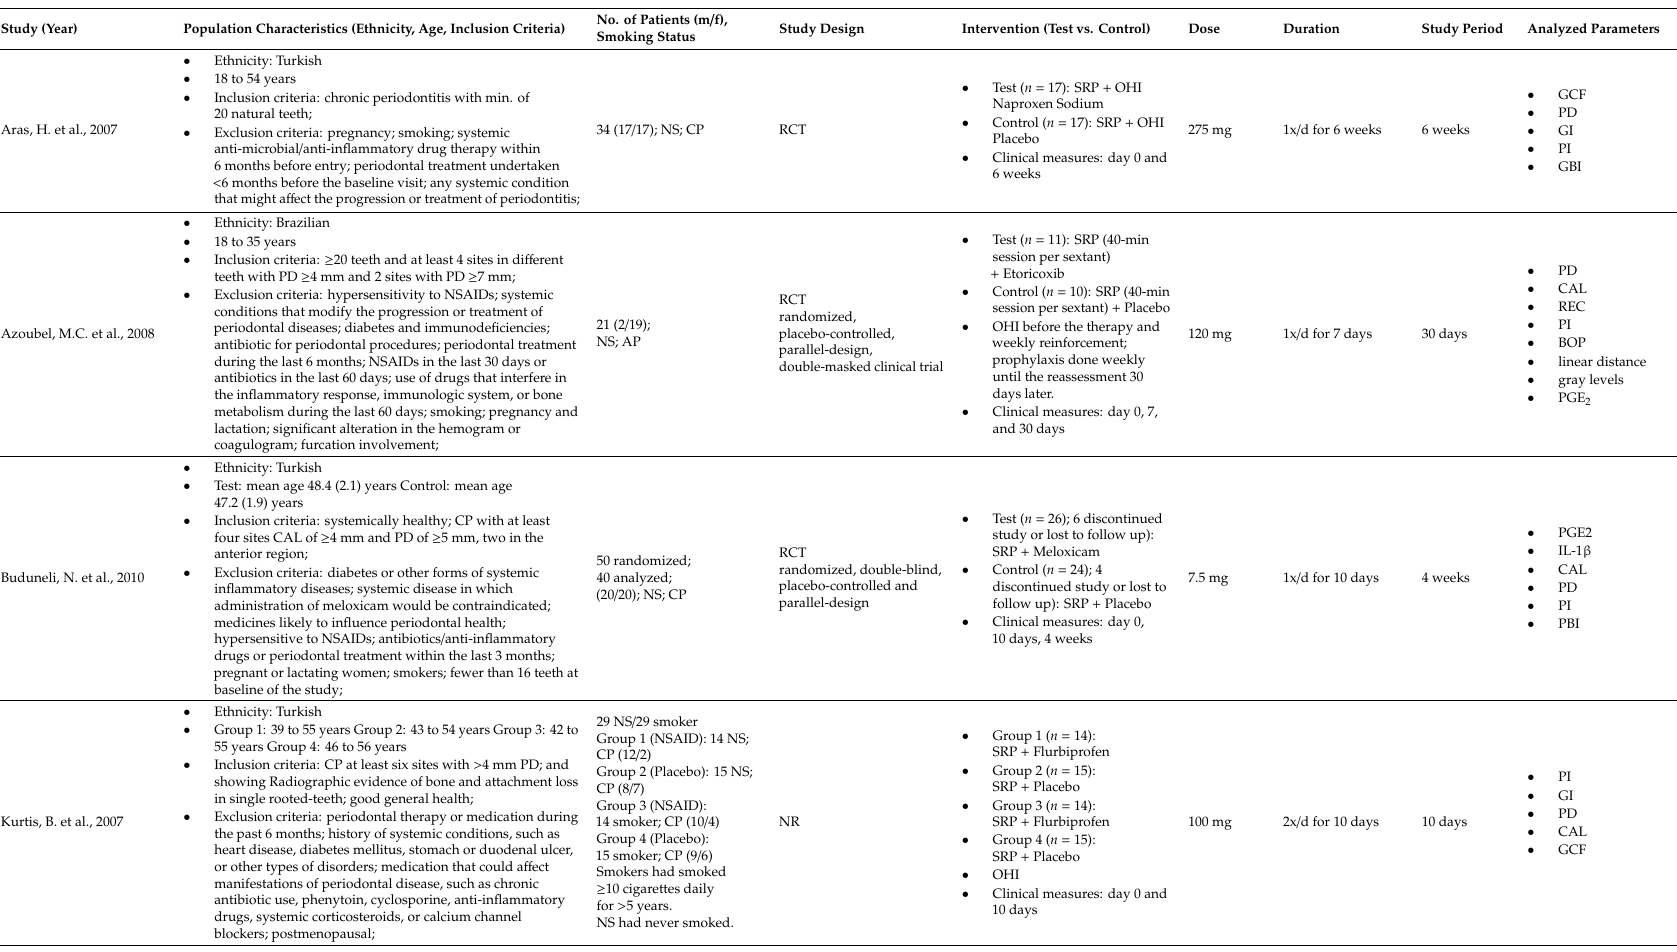
Table 1. Characteristics of the included publications comparing nonsteroidal anti-inflammatory drugs (NSAID)f to placebo. / f), Study(Year) PopulationCharacteristics(Ethnicity,Age,InclusionCriteria) No. ofPatients(m SmokingStatus StudyDesign Intervention(Testvs. Control) Dose Duration StudyPeriod